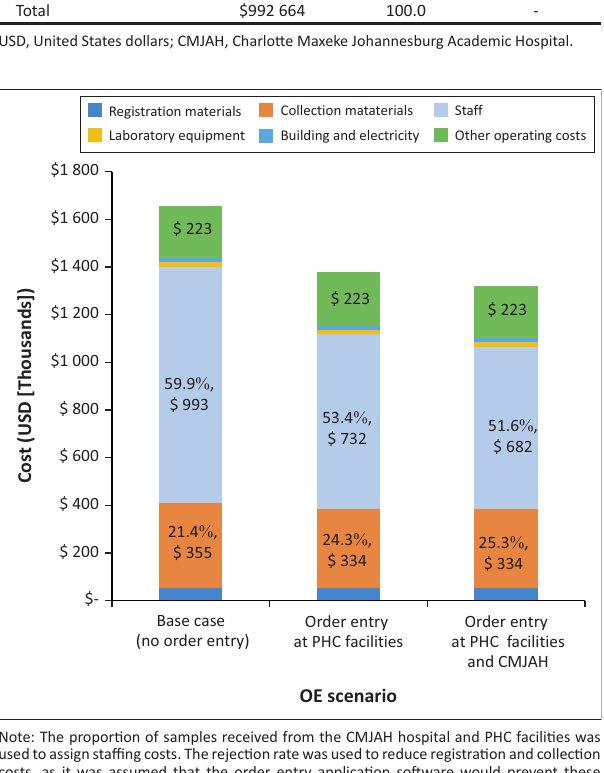
FIGURE 2: Impact of order entry implementation on the annual equivalent cost at the Charlotte Maxeke Johannesburg Academic Hospital (CMJAH) laboratory